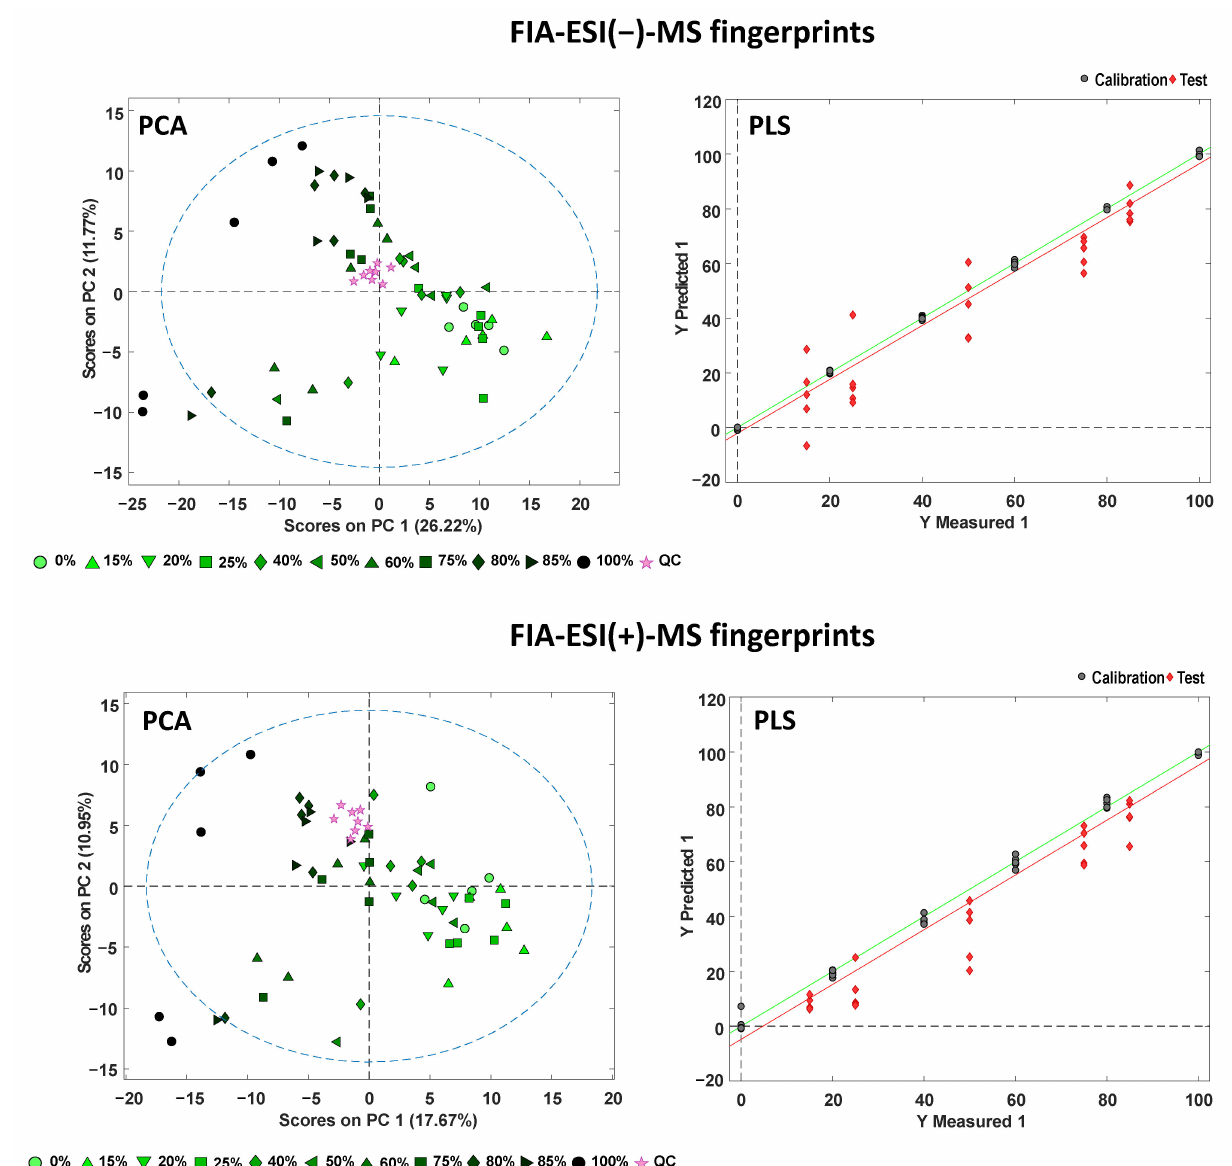
Figure 5. PCA score plots of PC1 versus PC2 and PLS scatter plots of measured versus predicted percentages of chicory for adulterated green tea by employing FIA-MS fingerprints in negative- and positive-ionization